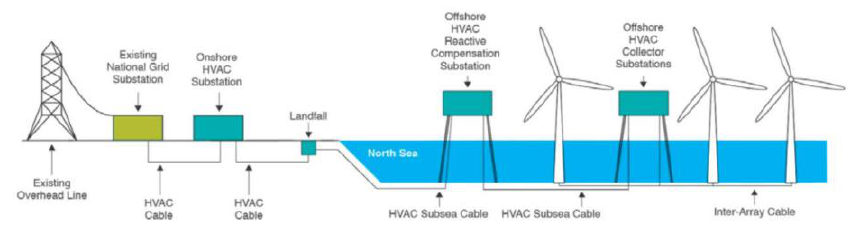
Figure 2. The basic layout description of the Hornsea wind farm.